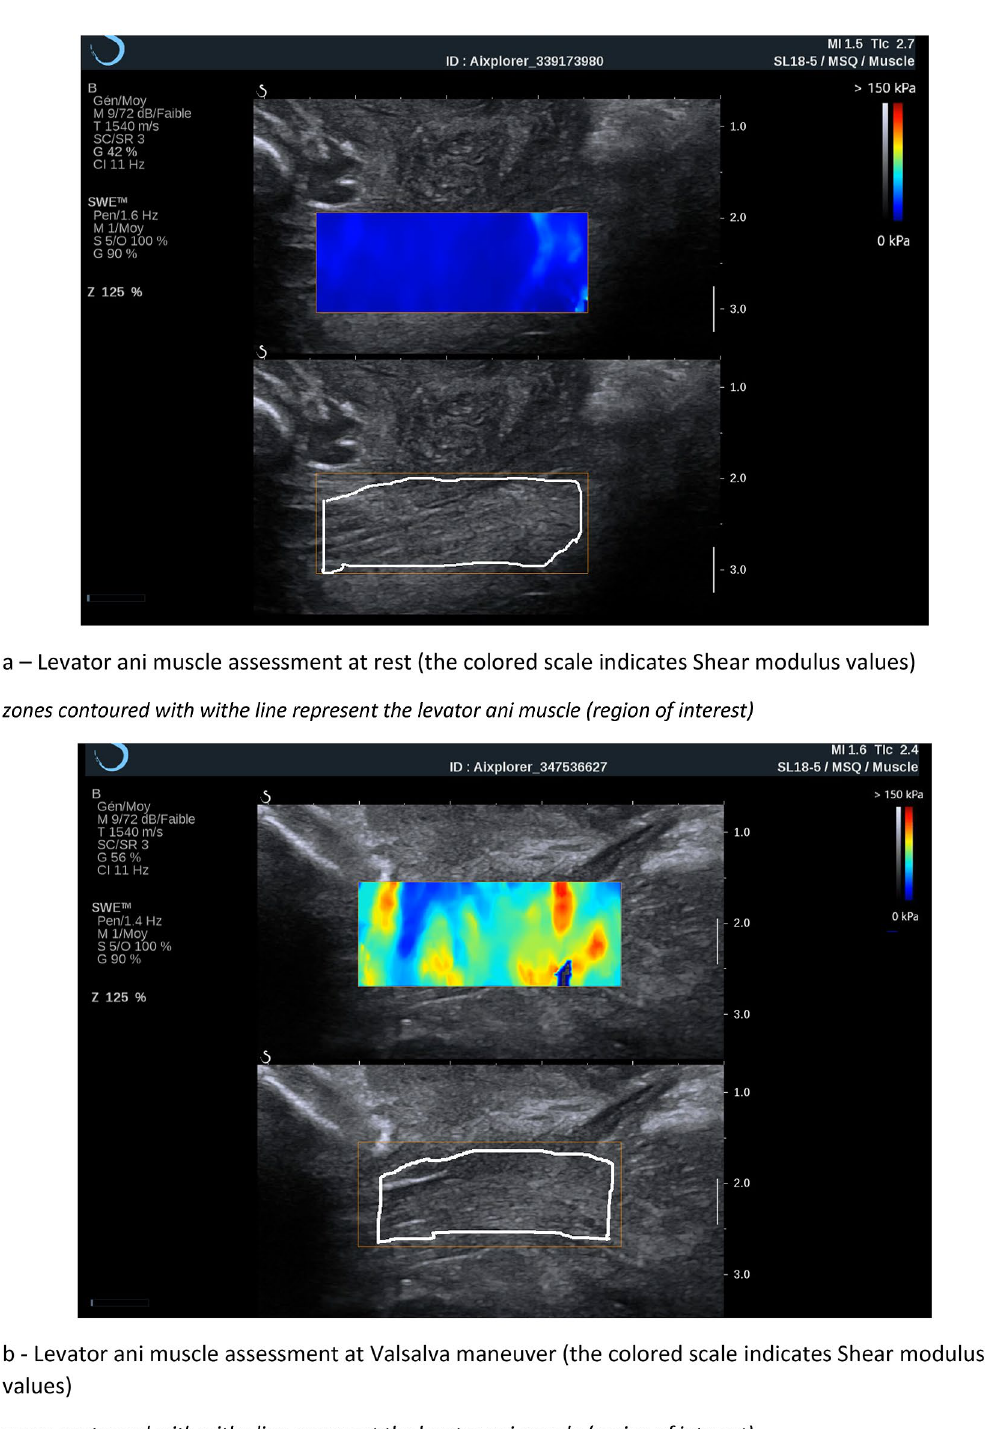
Figure 1. Assessment of the right levator ani muscle at rest ( a ) and Valsalva maneuver ( b